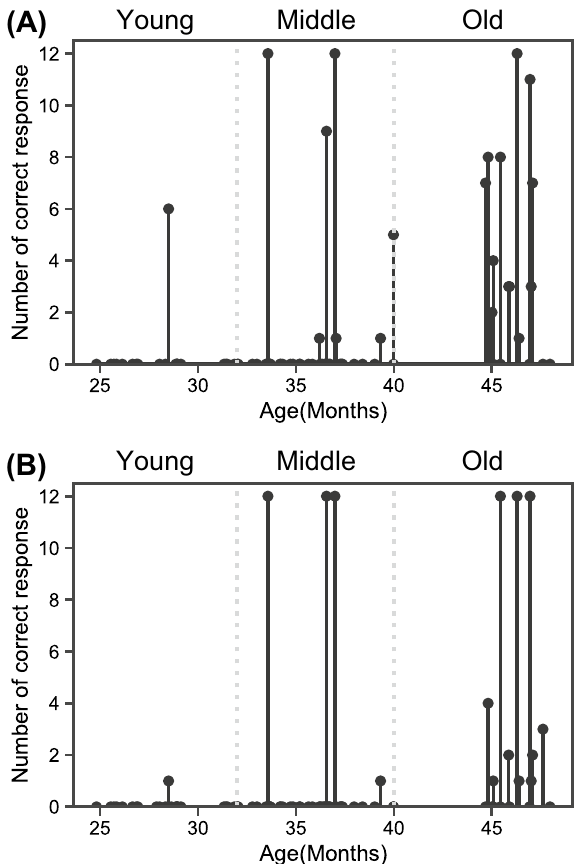
Figure 2. Toddlers’ reading attainment evaluated by ( A ) an experimenter and ( B ) their parents for toddlers in young (24–32 months), middle (32–40 months) and old (40–48 months)